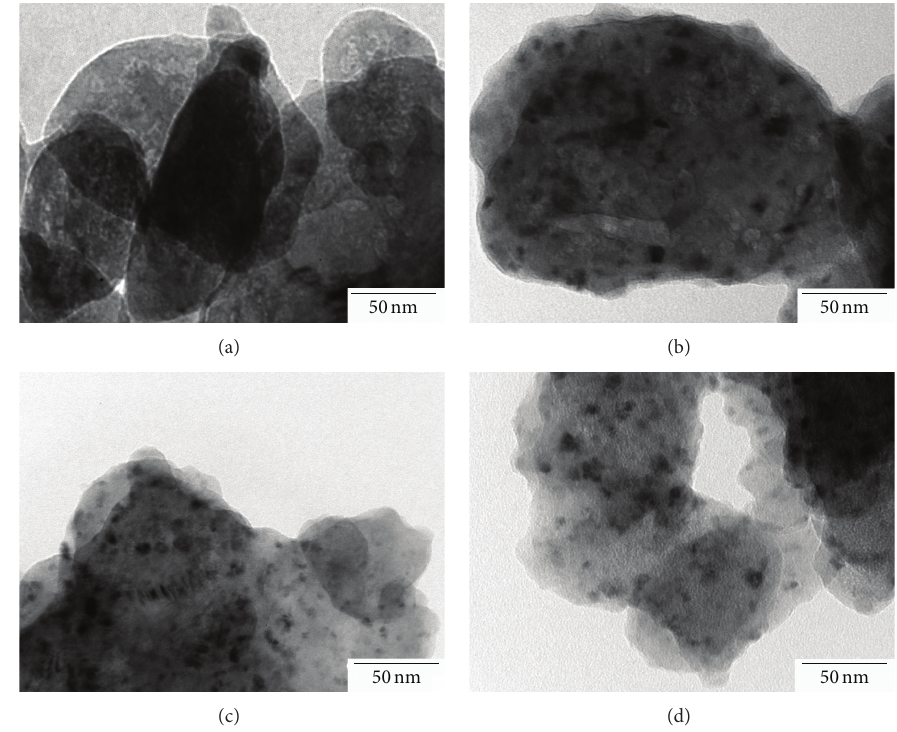
Figure 5: TEM micrographs of the HT wires: (a) Cu, (b) Ti, (c) SS, and (d)